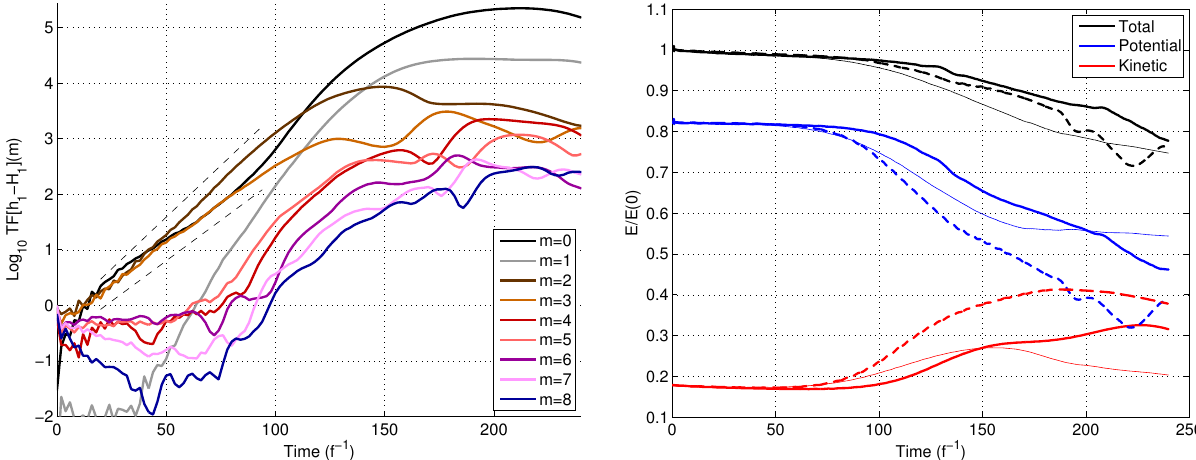
Figure 7. ( Left ): Evolution of the upper layer thickness perturbation (logarithm of norm) for different wavenumbers for the simulation with initial conditions randomly perturbed (several wavenumbers). Dashed lines indicate the estimated growth rate ( σ = 3.79 × 10 − 2 for m = 2 and σ = 2.91 × 10 − 2 for m = 3). ( Right ): Evolution of the energy anomaly (total: black, potential: blue, kinetic: red) normalized by the initial total energy anomaly. Thick continuous lines: perturbation containing a range of wavenumbers, thick dashed lines: perturbation with m = 2, thin continuous lines: perturbation with m = 3. Vortex parameters: δ = 0.2, Q 1 =